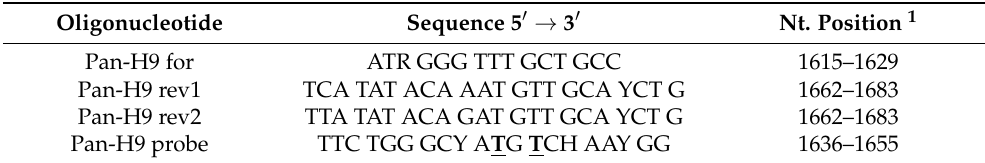
Table 1. Primers and probe of the pan-H9 rRT-PCR assay. LNA-modified bases are in bold and